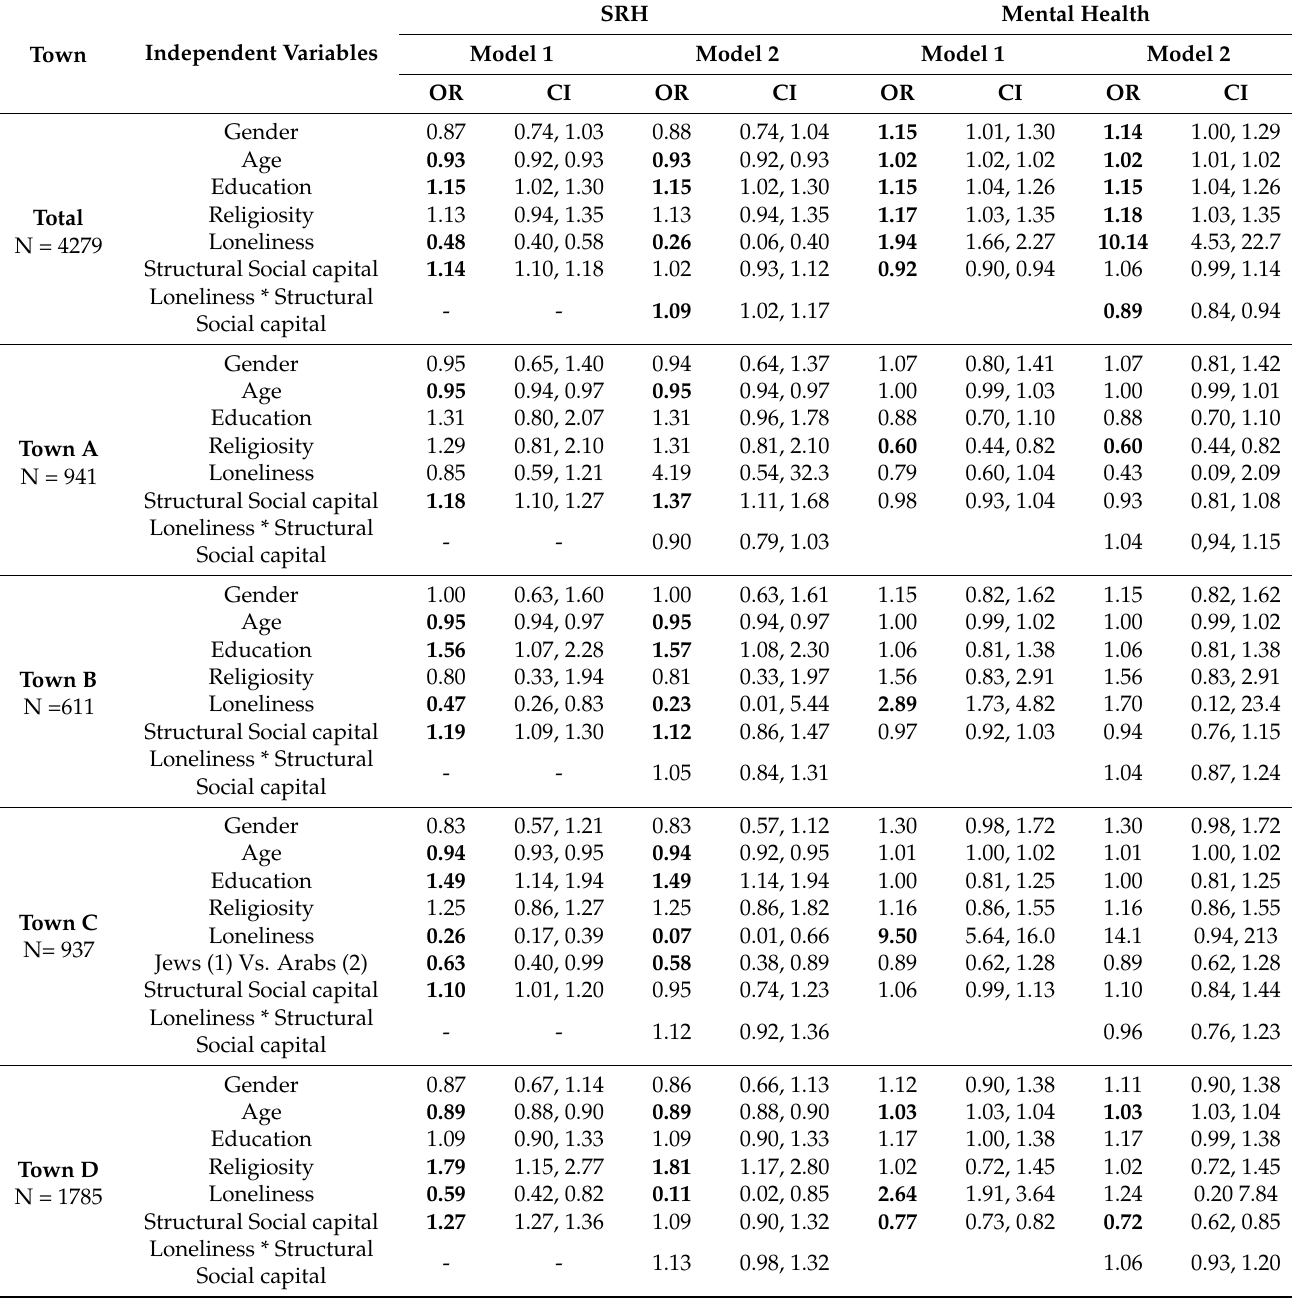
Table 4. Variables associated with self-rated health (SRH) and mental health, including structural social capital (participation in social activities). Logistic regressions presenting odds ratios (OR) and confidence intervals